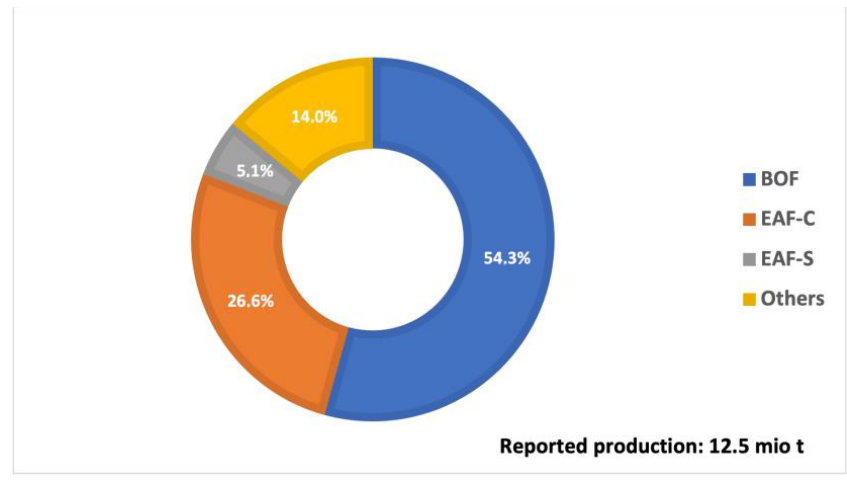
Figure 2. Production of steel slags in Europe in 2021 [4].